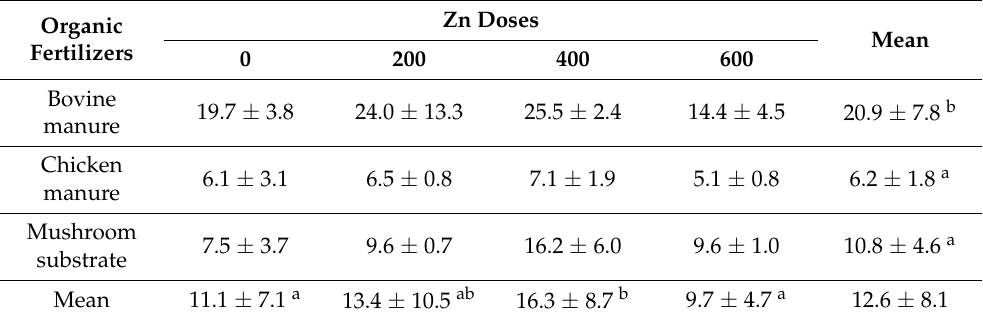
Table 7. Total phosphorus use efficiency (%) from applied organic materials in three years times under different zinc doses (Zn mg · kg − 1 of soil), (mean ± SD).